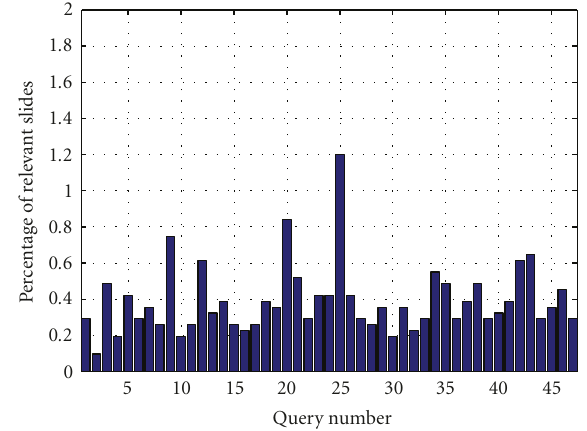
Figure 8: Percentage of the slides relevant to each query with respect to the database